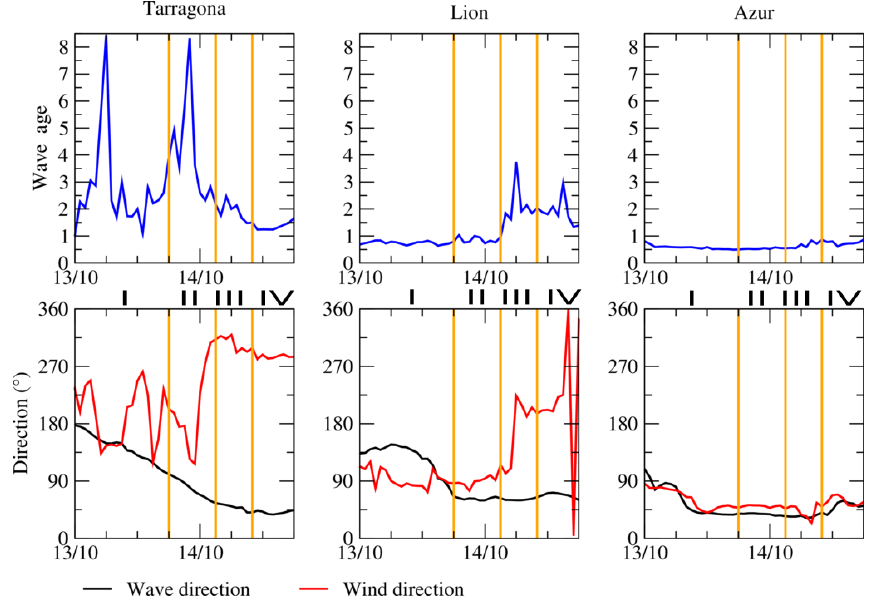
Figure 8. Evolution of the wave age (blue) and direction ( ◦ ) of local wind (red) and waves (black) simulated with AWF (WY) during the 13 October run at three different moored buoys. Orange lines limit the four different phases (I, II, III and